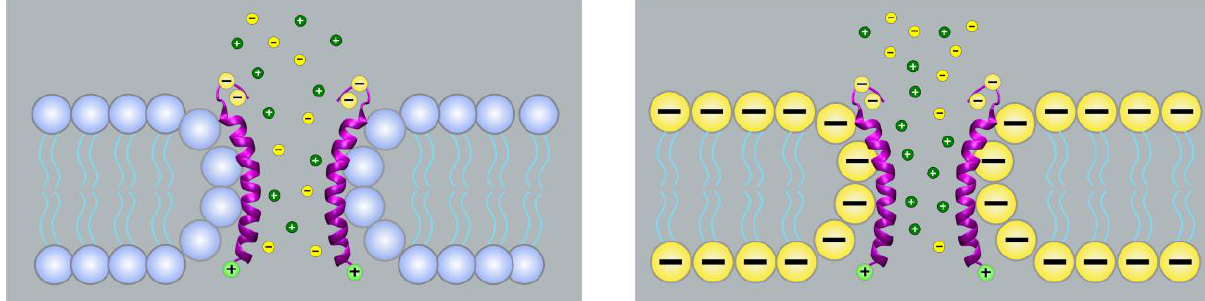
Figure 2. Functional involvement of lipid head groups in the protein-lipid pore formed by SARS-CoV E protein. Depictions represent E protein channels inserted in non-charged membranes (left) or negatively-charged membranes (right), under low solute concentrations and neutral pH. In these circumstances, each E protein monomer presents two negative charges provided by glutamic acid residues, and a positive charge conferred by an arginine. When reconstituted in fully or partially negatively-charged membranes, lipid head groups provide additional negative charges to the pore, which makes E protein channel more selective for cations and more conductive.